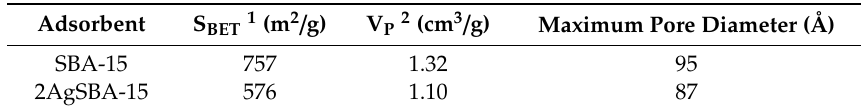
Table 1. Textural properties of the adsorbents.